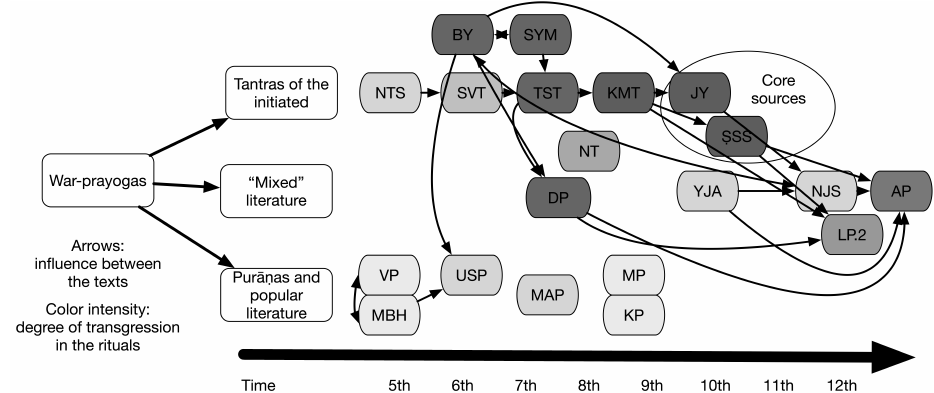
Figure 1. Relative chronology of the three lines: tantric (up), pur¯an. ic (down), and mixed